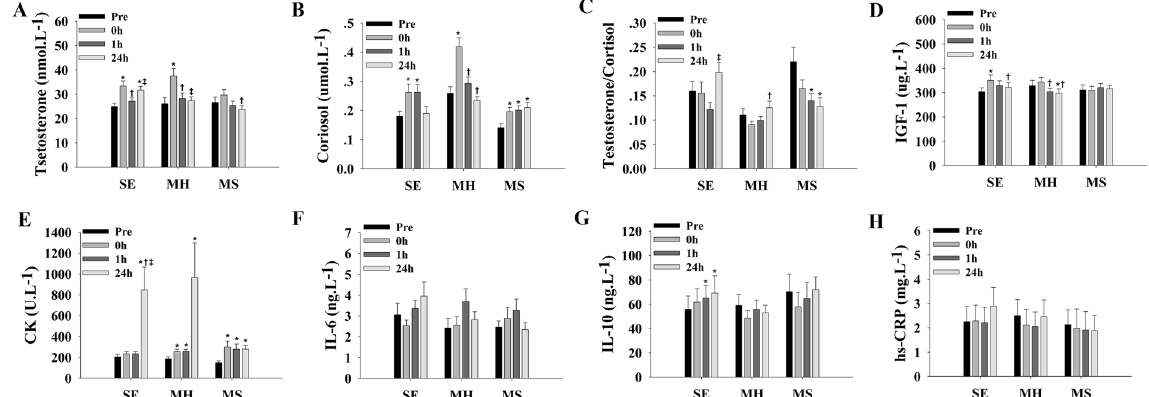
Figure 1. Alterations of blood parameters in response to three types of strength training protocol (n = 15 for each group). The plasma levels of hormones ( A,B,C and D ), muscle damage markers ( E ) and inflammatory cytokines ( F,G and H ) obtained at baseline (Pre), immediately after exercise (0 h), after 1 h of recovery (1 h) and after 24 h of recovery (24 h) for three resistance protocols (SE, MH, and MS). * indicates differences compared to Pre, p < 0.05; † indicates differences compared to 0 h, p < 0.05; ‡ indicates differences compared to 1 h, p < 0.05. Values represent the mean ± SEM.